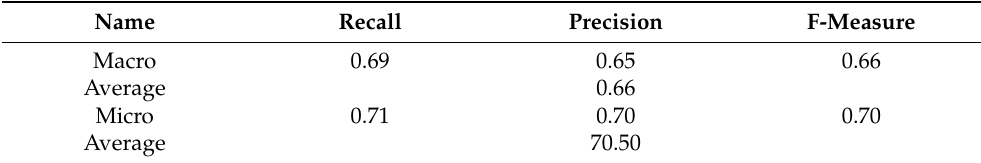
Table 7. The average performance of testing data on the CNN